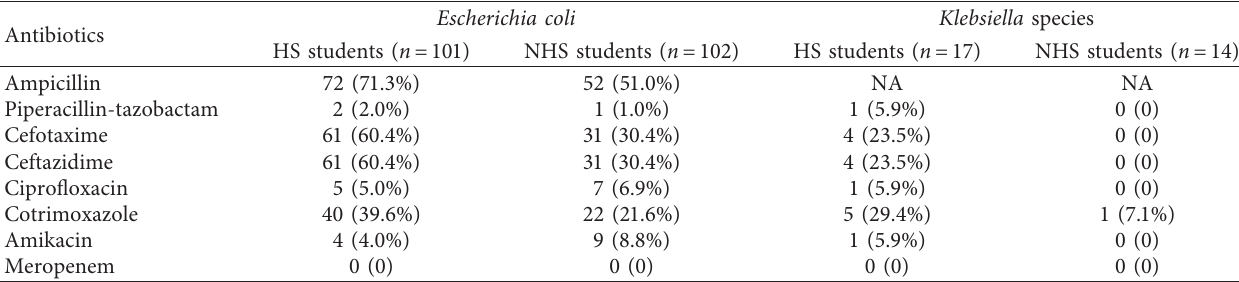
Table 5: Antibiotic resistance rates of bacterial isolates among HS and NHS students.